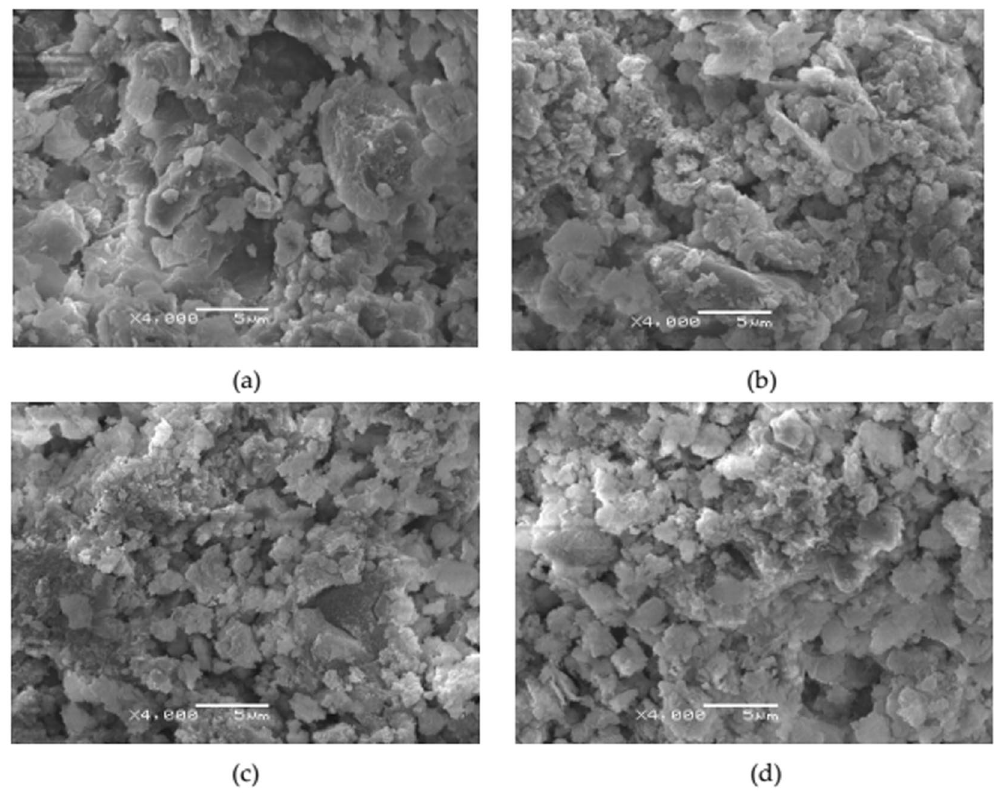
Figure 11. Scanning electron microscope image of catalyst. ( a ) Original sludge; ( b ) alkaline activated sludge; (c ) MnOx-based sludge (involved in the denitration reaction); ( d ) MnOx-based sludge (not involved in the denitration